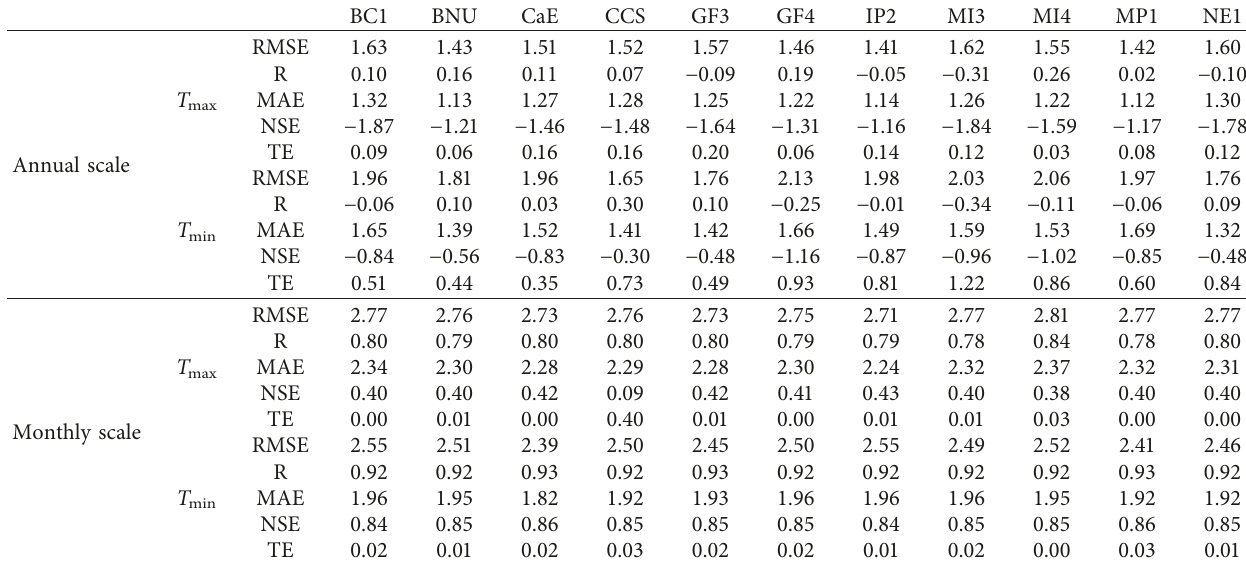
Table 6: The evaluation statistics by each climate model simulated at Xingren